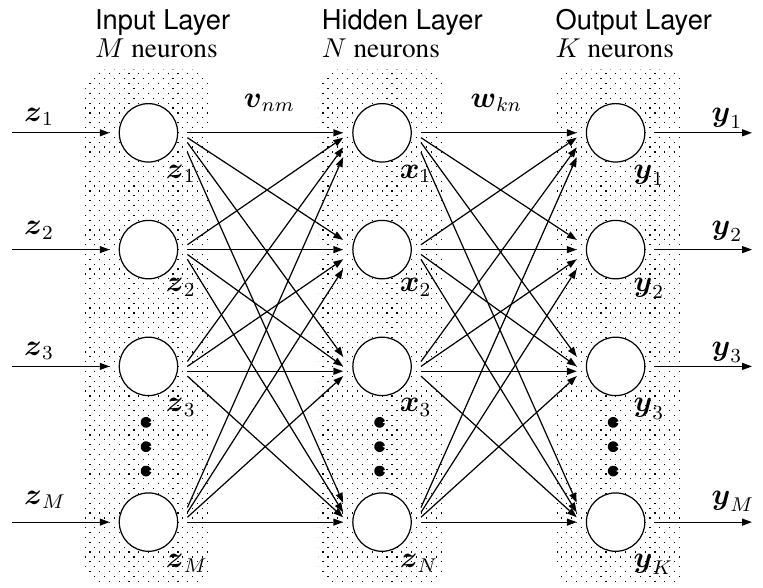
Figure 2. The structure of the multilayer perceptron in this